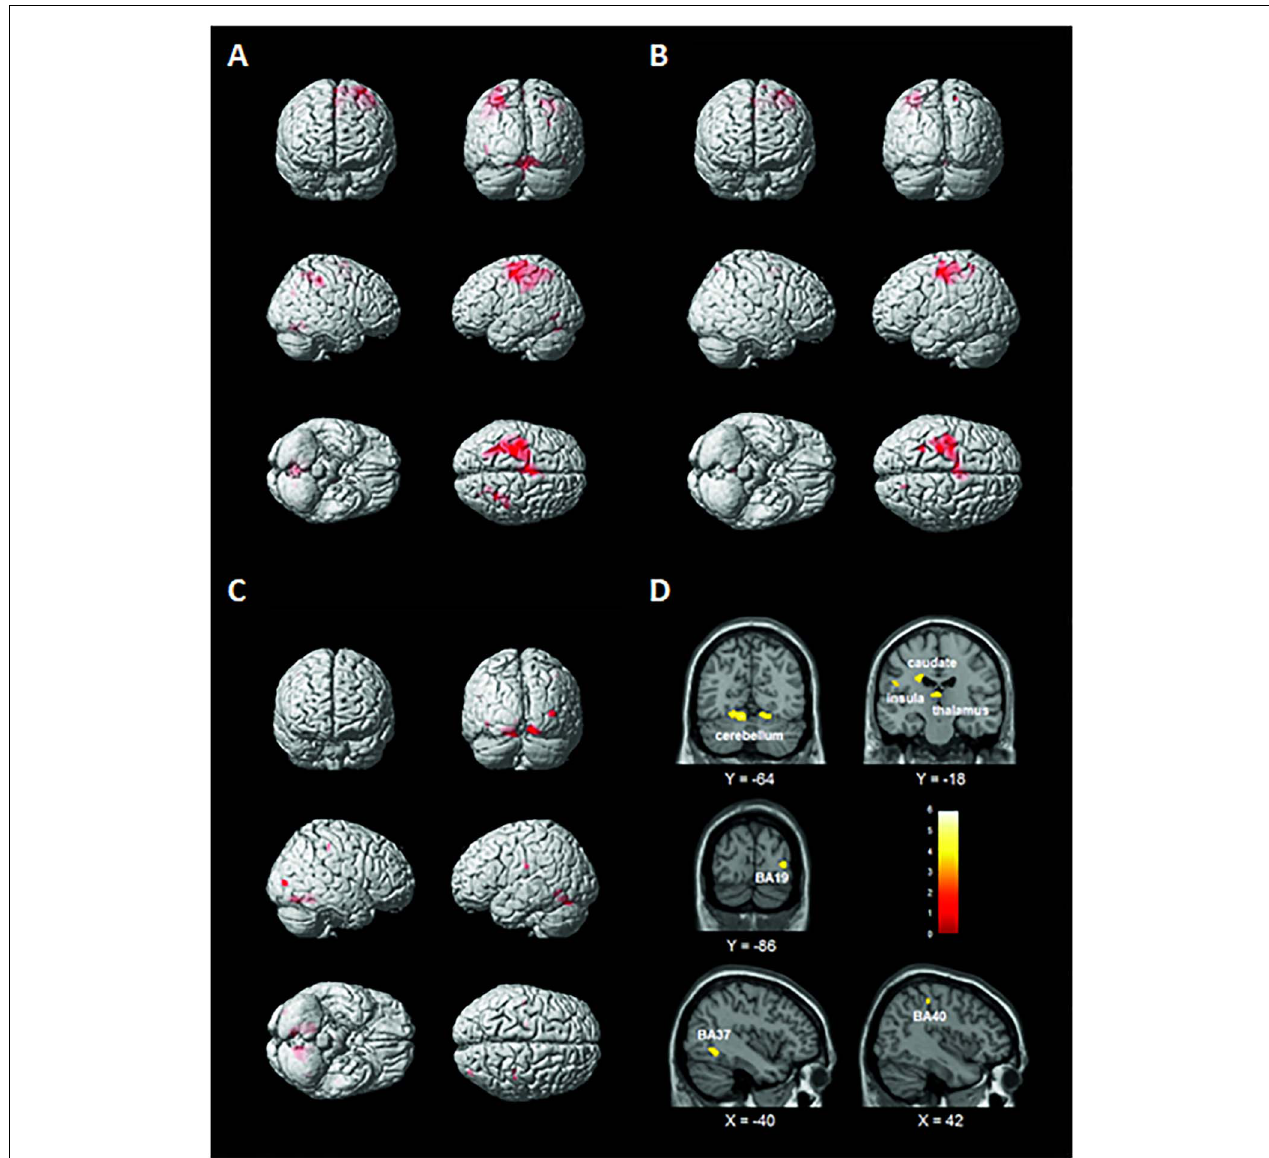
FIGURE 2 | Brain activation patterns elicited by the handwriting task displayed on a rendering surface. (A) Healthy controls (HC), (B) people with multiple sclerosis (PwMS), and (C) statistical contrast between the two groups (HC > PwMS). See Supplementary Table 2 . (D) Functional MRI (fMRI) sections reporting the clusters of activation found to be significantly more active in the HC than in the PwMS group during the handwriting task (statistical contrast: HC > PwMS). Images are displayed in neurological convention. See Table 2 for